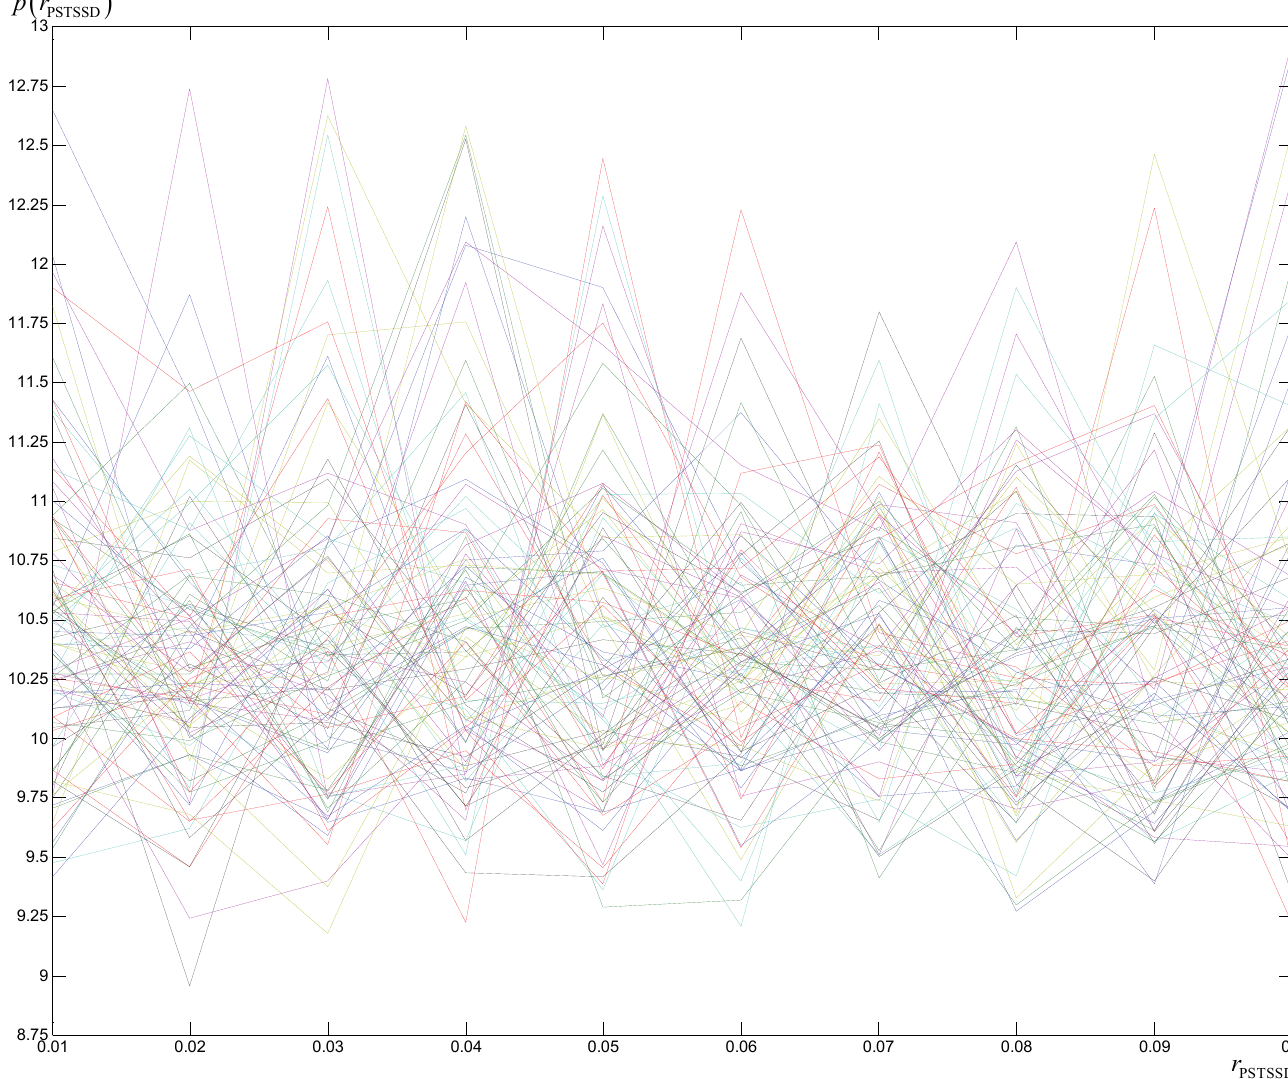
12.92 % via additional 438 passes of TS (2) for the best 2LP (30) by increasing the smoothness of the distortions with 80 P  (see article [29] for how TP is smoothed for improving the performance of 2LP).   * p  is seen in 0.08 Fig. 5. The distortions by SDs (31) appear ultimate, so the expected practicable SDs are smaller. They are about up to 0.7   by the corresponding 0.14   and 0.14   , where CEP is 1.64 %. Such a CEP is tolerable. Figure 6 visualizes STSOs by maximal SDs in (31), which form STSM6080Is of EEACLs successfully classified (the left-side images) with the best 2LP (30) further-trained [4], [28] with the 438 additional passes (438AP further-trained 2LP). Successful classification under lesser SDs is shown below. Those STSM6080Is classified incorrectly appear very much distorted (the right-side images) even under twice as small SDs. The most influential distortion is the shifting